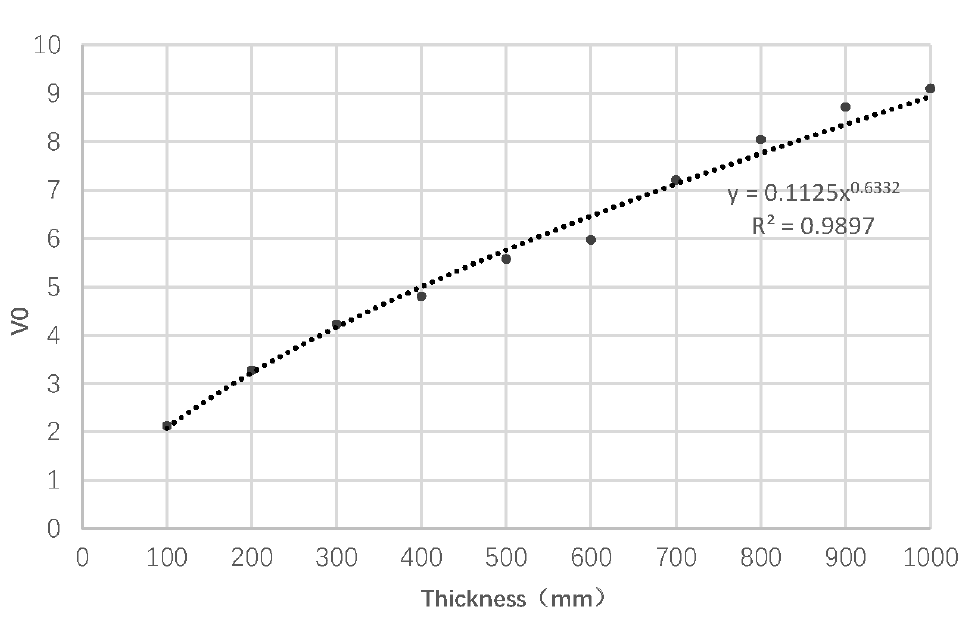
Figure 9. Fitting of the time lag. The calculation period of the delay time was chosen to be 24 h. The image shows that the thicker the wall, the greater the delay time. However, when the delay time was greater than 24 h, it became meaningless to continue enhancing the delay time for building indoor environmental stability. The sensitivity factor of the delay time in the comprehensive eval- uation index was calculated as 0.0434. 4.2.4. Thickness and Comprehensive Evaluation Index The comprehensive evaluation index was established according to the four-parame- ter influence factor fitted above, as shown in Equation (8). The comprehensive evaluation index under each wall thickness was then calculated and is shown in Figure 10. M = 0.7354 β 1/U + 0.016 β D + 0.6332 V 0 + 0.0434 β ξ